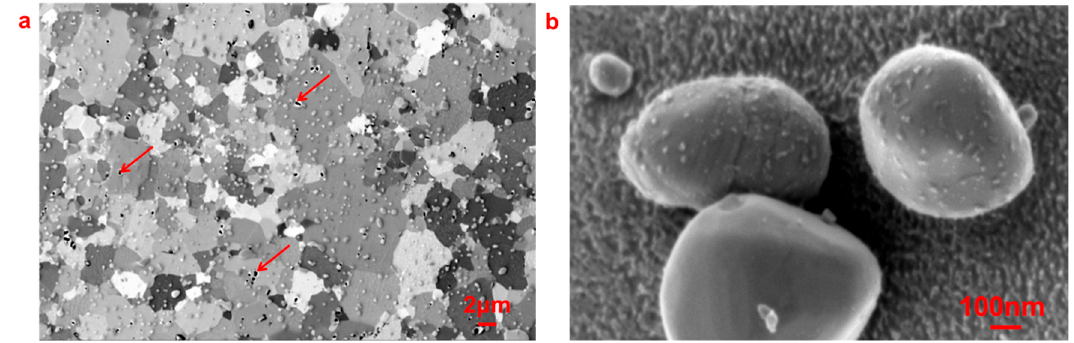
Figure 2. ( a ) AsB SEM image of Type 420 stainless steel with the arrows showing voids, and ( b ) typical size and shape of chromium carbides.